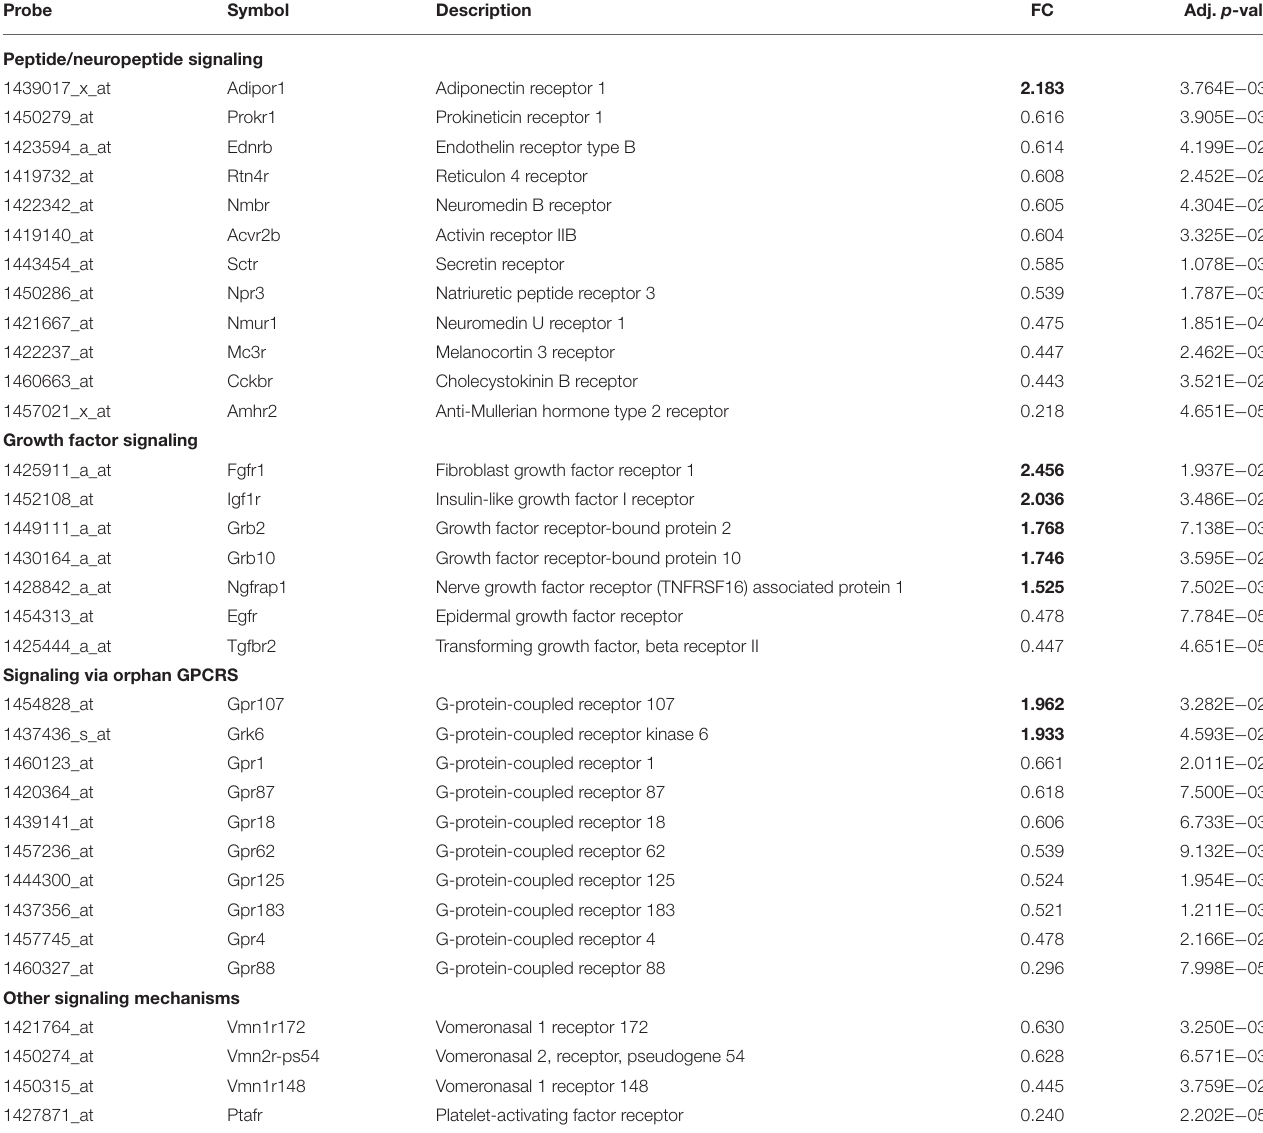
TABLE 1 | Differentially expressed genes encoding peptide-, growth factor-, and orphan GPCR receptors in GnRH neurons. Probe